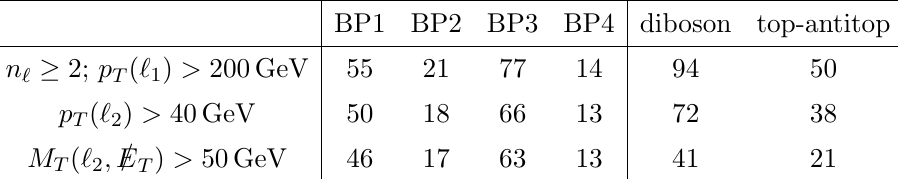
Table 5 . Number of events surviving each step of a typical LRSUSY selection targetting